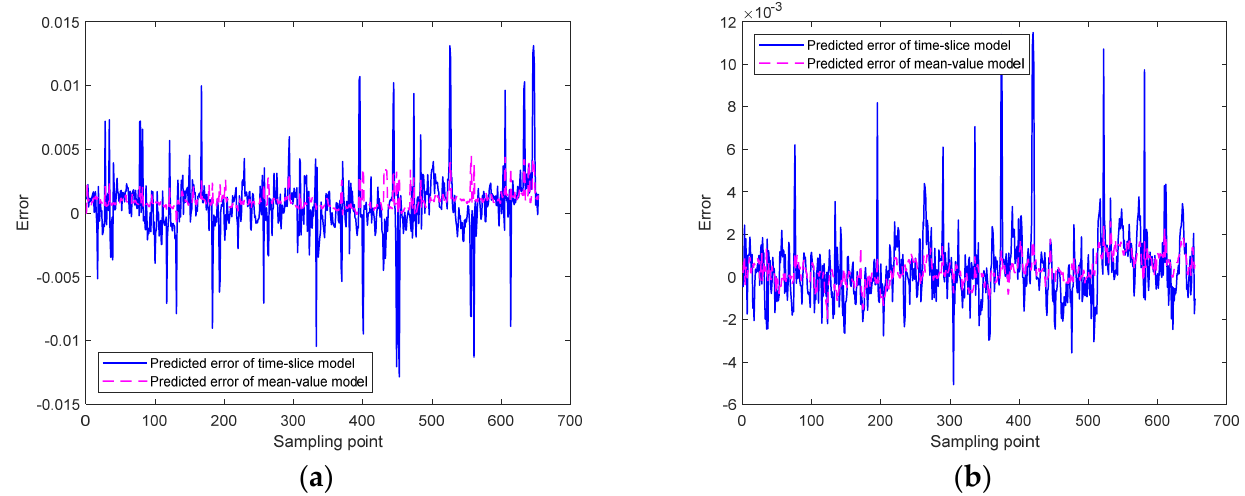
Figure 3. Mach number prediction errors of the time-slice PLS and mean-value models. ( a ) Mode 1. ( b ) Mode 2.